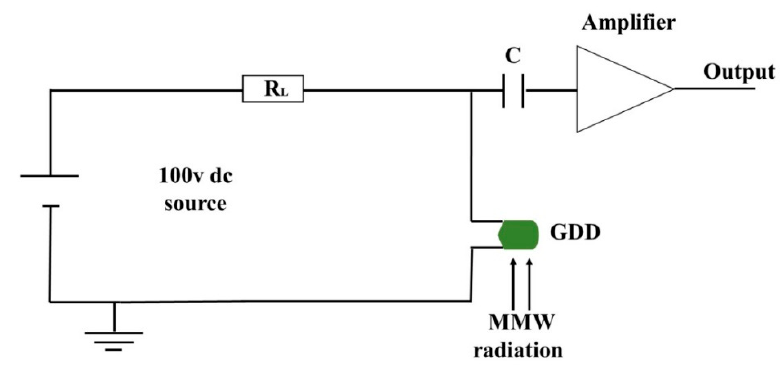
Figure 2. The glow discharge detectors (GDD) electrical circuit.